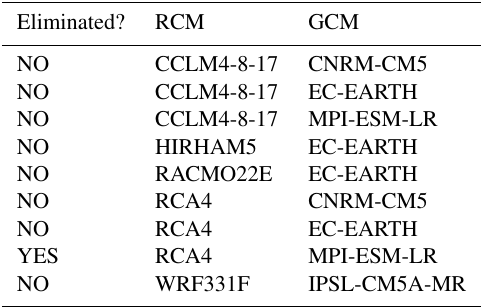
Table 2. Eliminated and non-eliminated models in the multiple- criteria